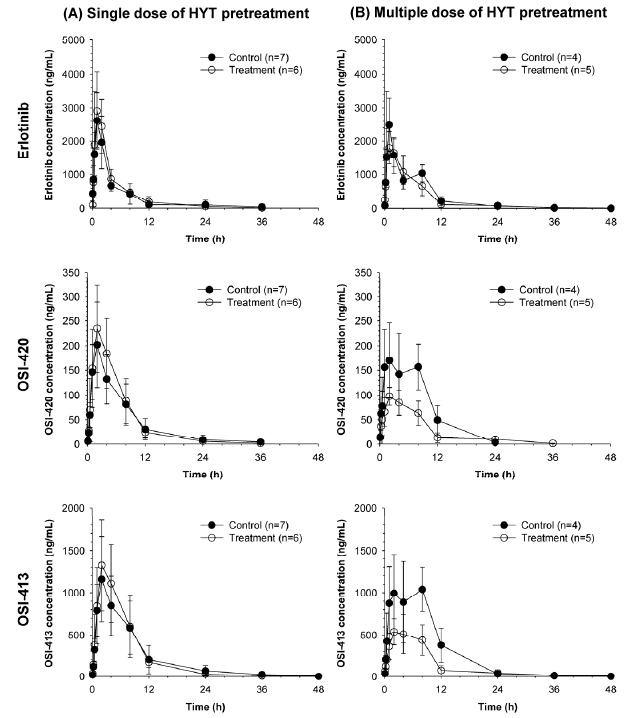
Figure 2. Average plasma concentration vs. time profiles of erlotinib, OSI-420, and OSI-413 following administration of the combination of anticancer agent; gemcitabine (i.v., 10 mg/kg) and erlotinib (p.o., 20 mg/kg) to rats pretreated with 1% CMC-Na (Control) or Hyangsayukgunja-tang (HYT) 1200 mg/kg as ( A ) a single dose or ( B ) multiple doses for 14 days.